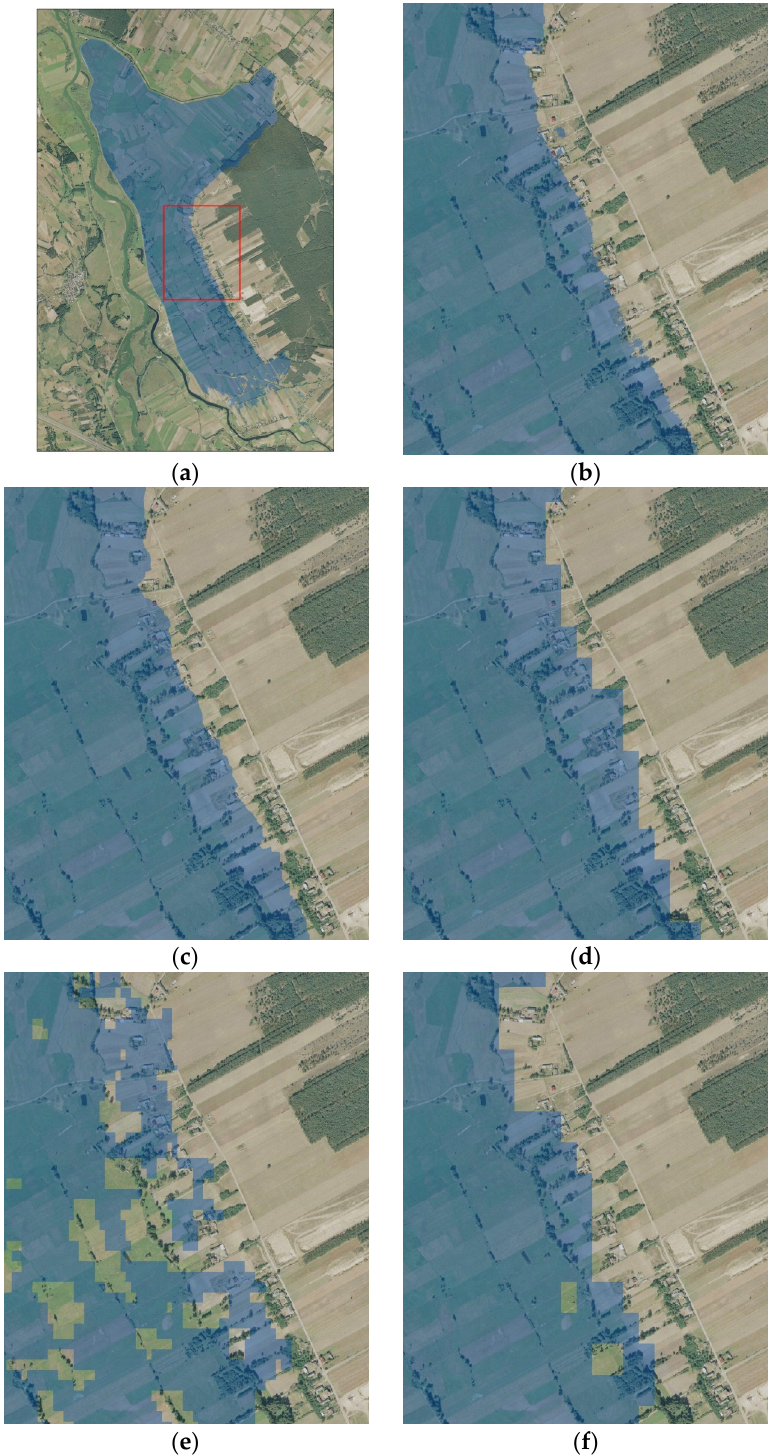
Figure 10. Flood zones in the Majdany area as defined with LIDAR, Airborne, ASTER, SRTM and SRTM_cor, ( a ) Polder, red area—Majdany village in magnification in the figure b – f ; ( b ) LIDAR-DEM; ( c ) Airborne-DEM; ( d ) ASTER-DEM; ( e ) SRTM-DEM; ( f ) SRTM_cor-DEM.